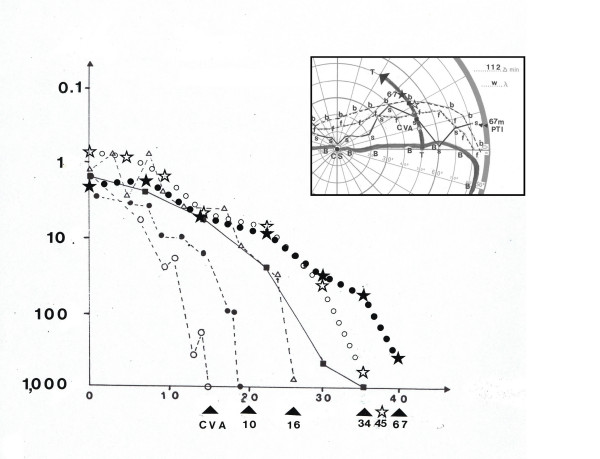
Change of threshold curves within a 67 months post traumatic interval. Large image. Incremental thresholds along a circle of 50 deg eccentricity (zenith angle Φ) of the treated upper right VF quadrant in a patient (# 20) suffering from a bilateral infarction of the posterior cerebral arteries and a simultaneous infarction of the left thalamus at different times after CVA. CVA 1 month after bilateral insult, immediately before the beginning of treatment with LRP. 10, 16, 34, 45, 67 refer to measurements at post traumatic interval (PTI) months after CVA. Open circles = 1 month after CVA Filled circles = CVA + 10 months at the end of treatment phase 1 (= 11 months after CVA) Open triangles = CVA + 16 months Filled squares = CVA + 34 months Open stars = CVA + 45 months Filled stars = CVA + 67 months. Abscissa = polar (or azimuth angle) Θ [deg] 0 = right horizontal meridian 90 = upper vertical meridian Ordinate = incremental (luminance) threshold T = ΔL/L, background luminance L = 3,2 cd/m2, stimulus duration Δ t = 200 ms, circular stimulus ∅; = 112', stimulus color = white. Small image. Subjective brightness estimation, and VF borders of threshold, brightness and form perception within a part of the central VF of pat #20 with accentuation of the treated (phase 1) upper right VF quadrant. CS central comparison stimulus (subjective brightness : 100) CVA VF border on eccentricity circle Φ = 50° when measured by incremental thresholds T one week after CVA symbols VF border (incremental threshold T) as in large image 67 VF border (incremental threshold T) 67 months after CVA 67 months PTI (and curve of filled squares) subjective brightness estimation curve "100 %" (= to brightness of CS) 67 months after CVA b VF border (brightness perception) measured by kinetic perimetry 67 months after CVA f VF border for form perception (100% correct discrimination of white circles and squares of equal size and luminance measured by kinetic perimetry.